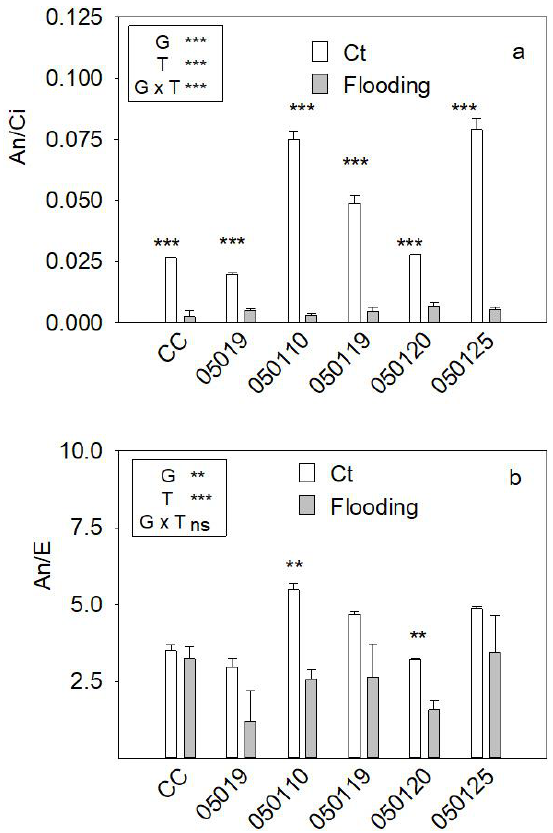
Figure 4. ( a ) Instantaneous carboxylation efficiency (An/Ci) and ( b ) instantaneous water use effi- ciency (An/E) in young and well-developed (fully expanded) leaves from five citrus hybrids grown for 35 days in the non-stressed (Ct) or flooding treatment. Values are the means of six independent seedlings ( n = 6). In each hybrid, comparisons among treatments were made by Fisher’s least sig- nificance difference (LSD) test. * p < 0.05, ** p < 0.01, *** p < 0.001, ns: not significant. CC: Carrizo citrange; G: genotype, T: treatment.